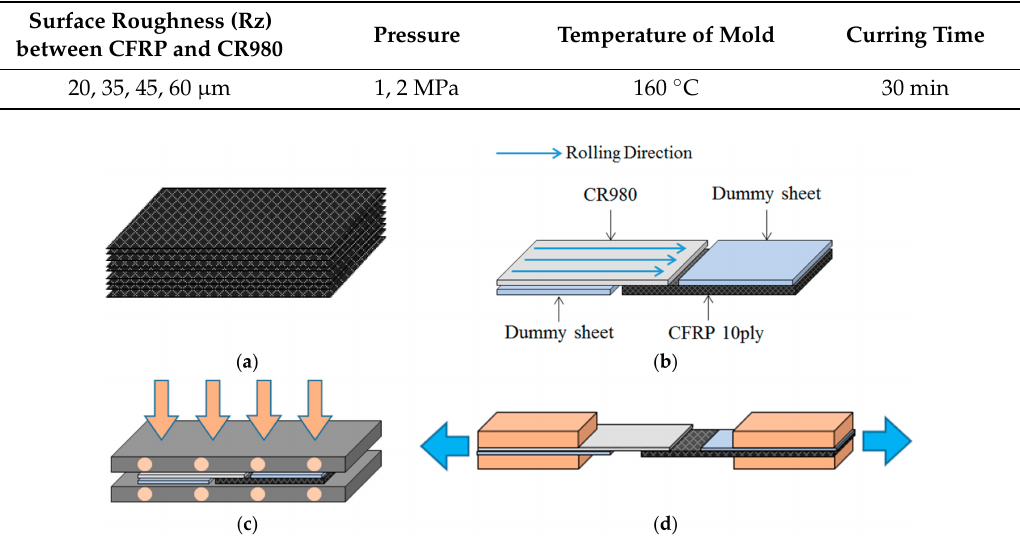
Table 3. Parameters of the hot compression molding process.